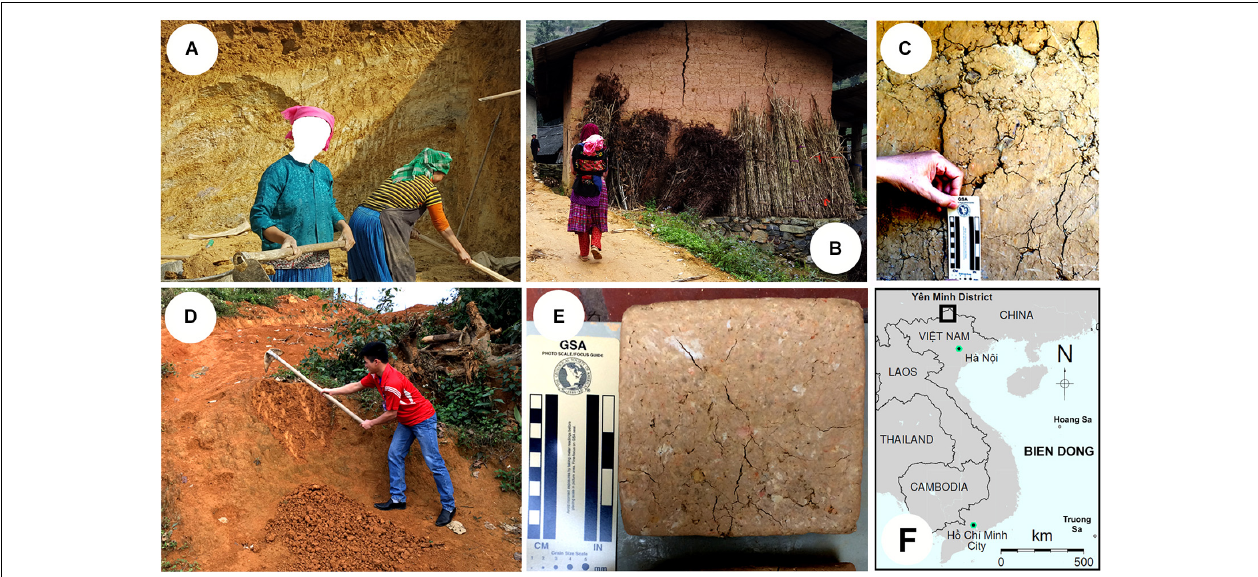
FIGURE 1 | (A) Local mining of terra rossa for the construction of (B) Mud houses in the Ð`ông V˘an Karst Plateau Geopark, Hà Giang Province, northern Viê.t Nam. (C) Closeup view of the exterior wall of a mud house. The scale on the left is in cm. (D) Collecting terra rossa in Yên Minh District for manufacturing of (E) Mud bricks in the laboratory to measure 220 Rn exhalation rates. (F) The black rectangle on the map of Viê.t Nam indicates the location of the Yên Minh District where terra rossa was mined for mud houses and mud bricks. Pictures of quarry (A) and mud house (B) courtesy of Jian Liu, Indiana